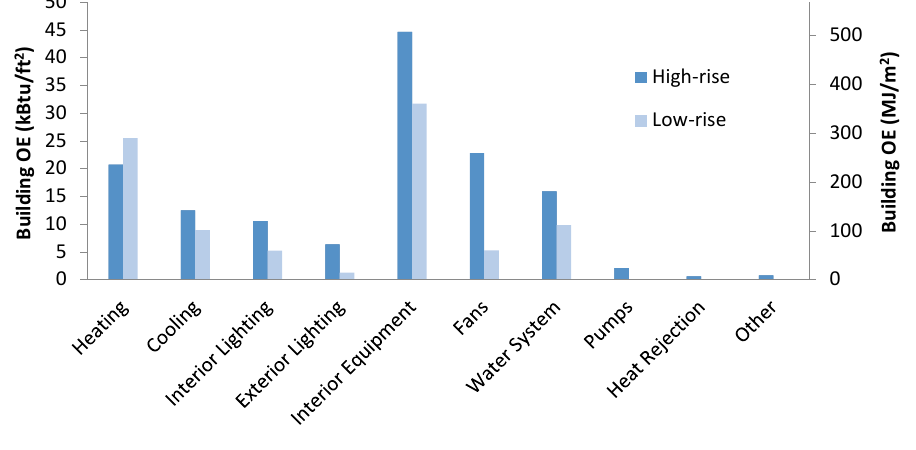
Figure 3. High-rise (STD 2013) vs. low-rise (IECC 2012) building end use operational energy (OE) for the U.S. DOE prototype building